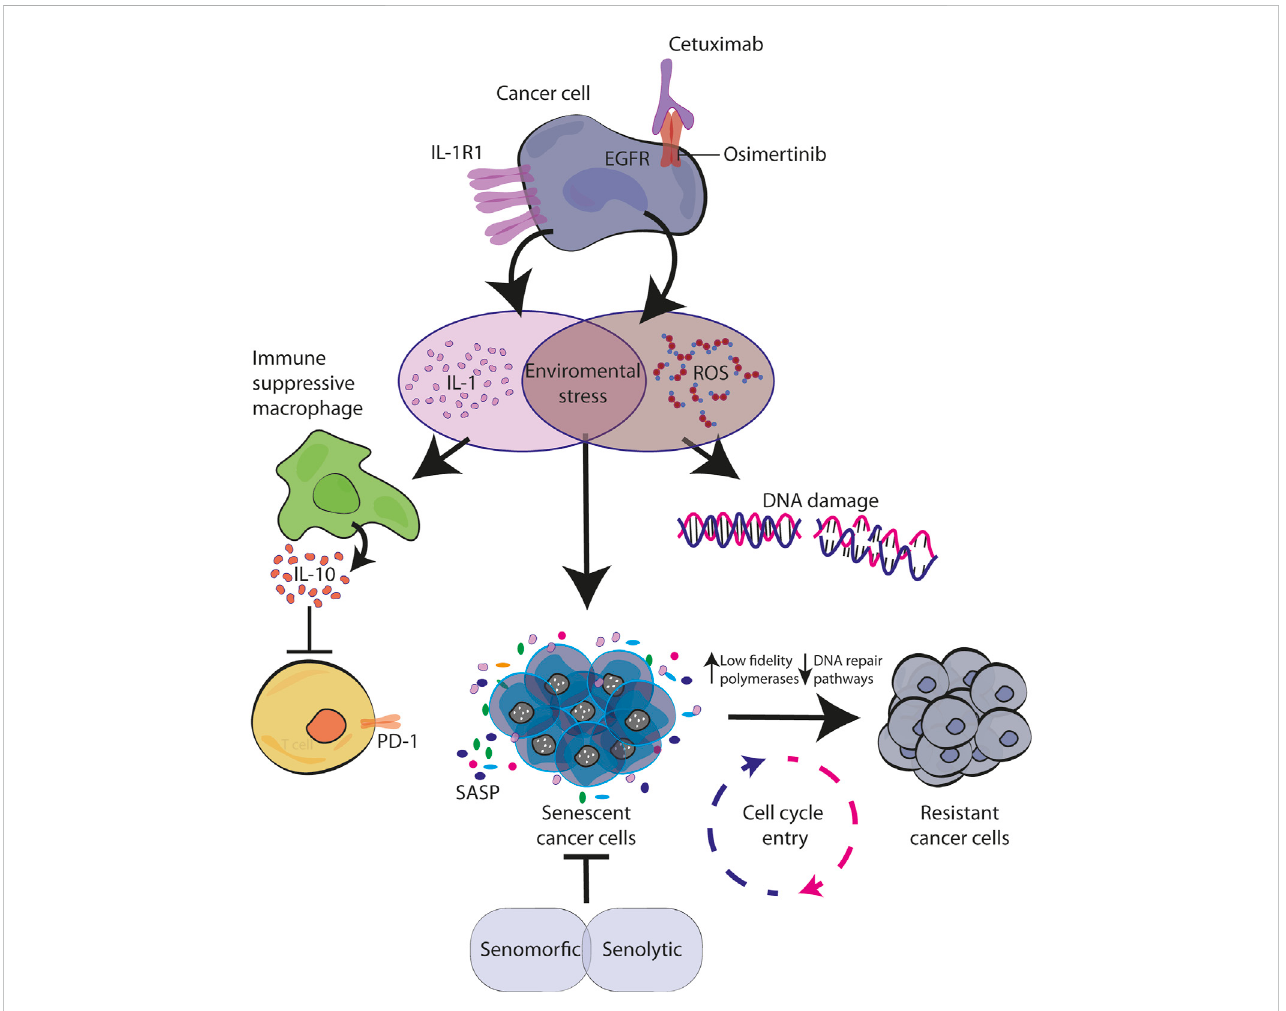
FIGURE 2 Senescence activated by environmental stress causes resistance to EGFR blockade. EGFR targeted therapy activates stress response in cancer cells characterized by IL-1 and ROS production. By creating a pro-in fl ammatory environment with immunosuppression function and by inducing DNA damage, they both contribute to the establishment of senescence in autocrine and paracrine manner. During this time, the increased levels of error-prone DNA polymerases allow cell cycle re-entry of drug-resistant mutagenic variants which ultimately converge for tumor relapse (Kaplanov et al., 2019; Singh et al., 2021; Romaniello et al.,